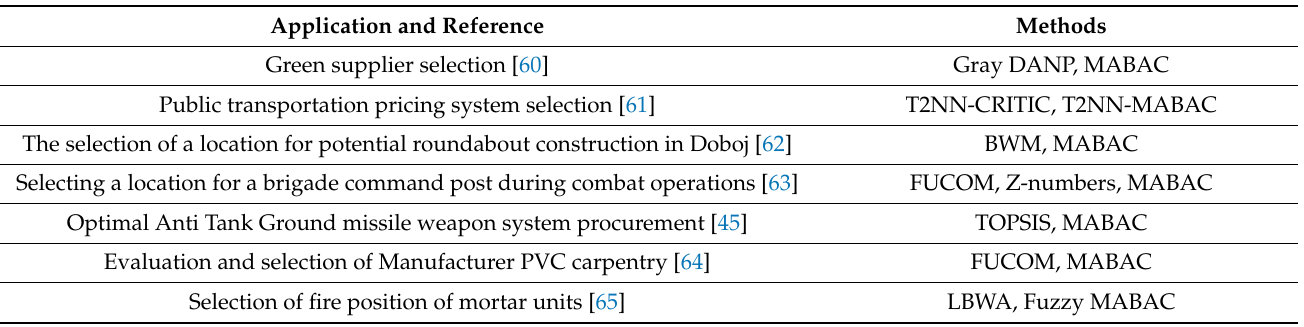
Table 2. MABAC method—analysis of the literature.